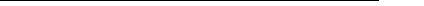
Figure 4 . The ν µ disappearance probability at DUNE for a modulating ∆ m 2 in the dynamical regime, for different values of the ratio between the period of the modulation τ φ and the neutrino time of flight τ ν